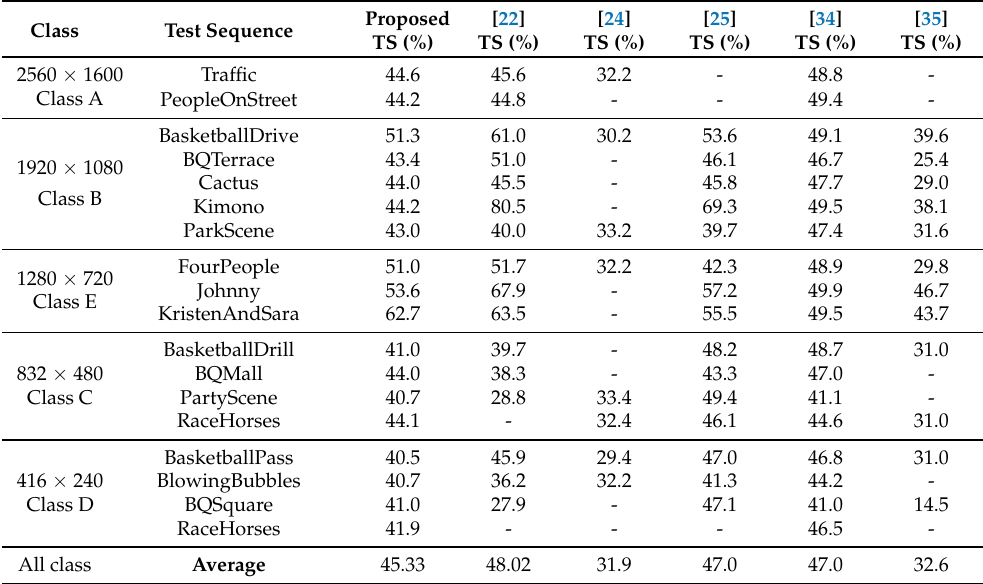
Table 6. The time savings of the proposed method compared with the anchor method and previ- ous works.